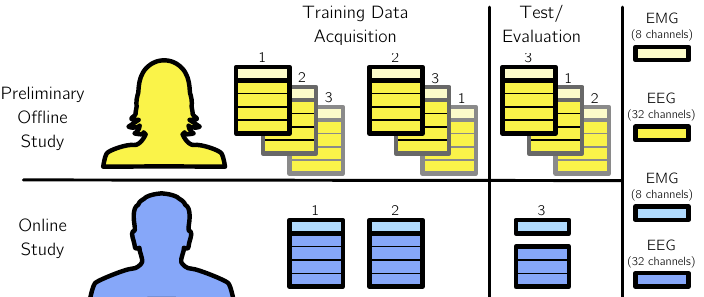
Figure 5. Illustration of the online evaluation/offline cross validation scheme (see also Section 5.3). In the preliminary offline study, three runs of data were recorded in total. The runs of the data were used as splits for the cross validation as follows. All combinations of runs in a session were used, resulting in three different training/evaluation combinations. Two recorded runs were used for training of the data dependent methods and the remaining run was used for the offline evaluation. In each run the data was recorded using the Magma-Box-Setup, i.e., it consisted of 4 32 = 128 channels of EEG × data and 8 channels of EMG data. Due to the restrictions of the recording hardware discussed in the text, a modified recording scheme was used for the offline evaluation. Online evaluation: In this case, the two initial training sets were recorded using the Magma-Box-Setup. In the test/evaluation phase, a single run was recorded using the USB-Box-Setup. The physiological data was processed in real-time and the results recorded for subsequent